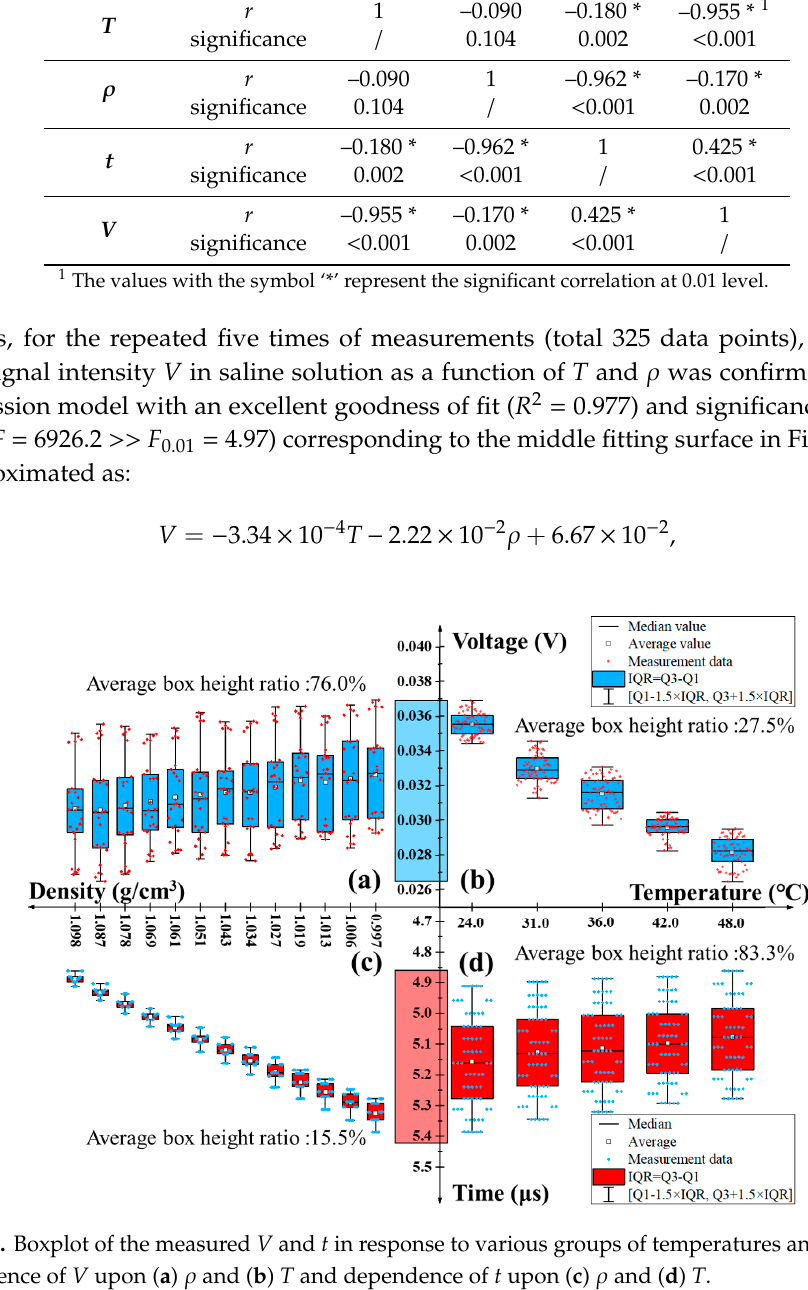
Table 1. Calculated Pearson correlation coe ffi cients of the variables T , ρ , t and V .